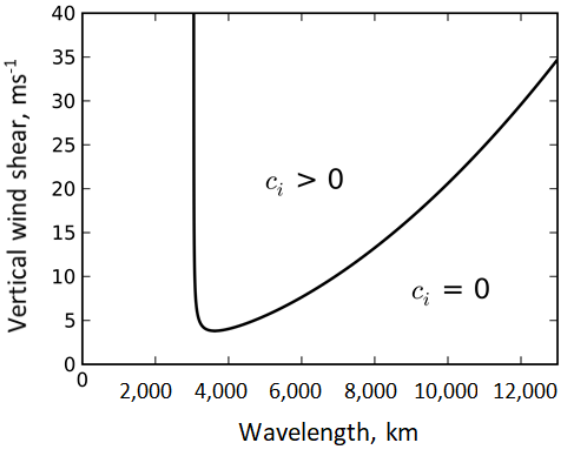
Figure 3. Marginal stability curve.